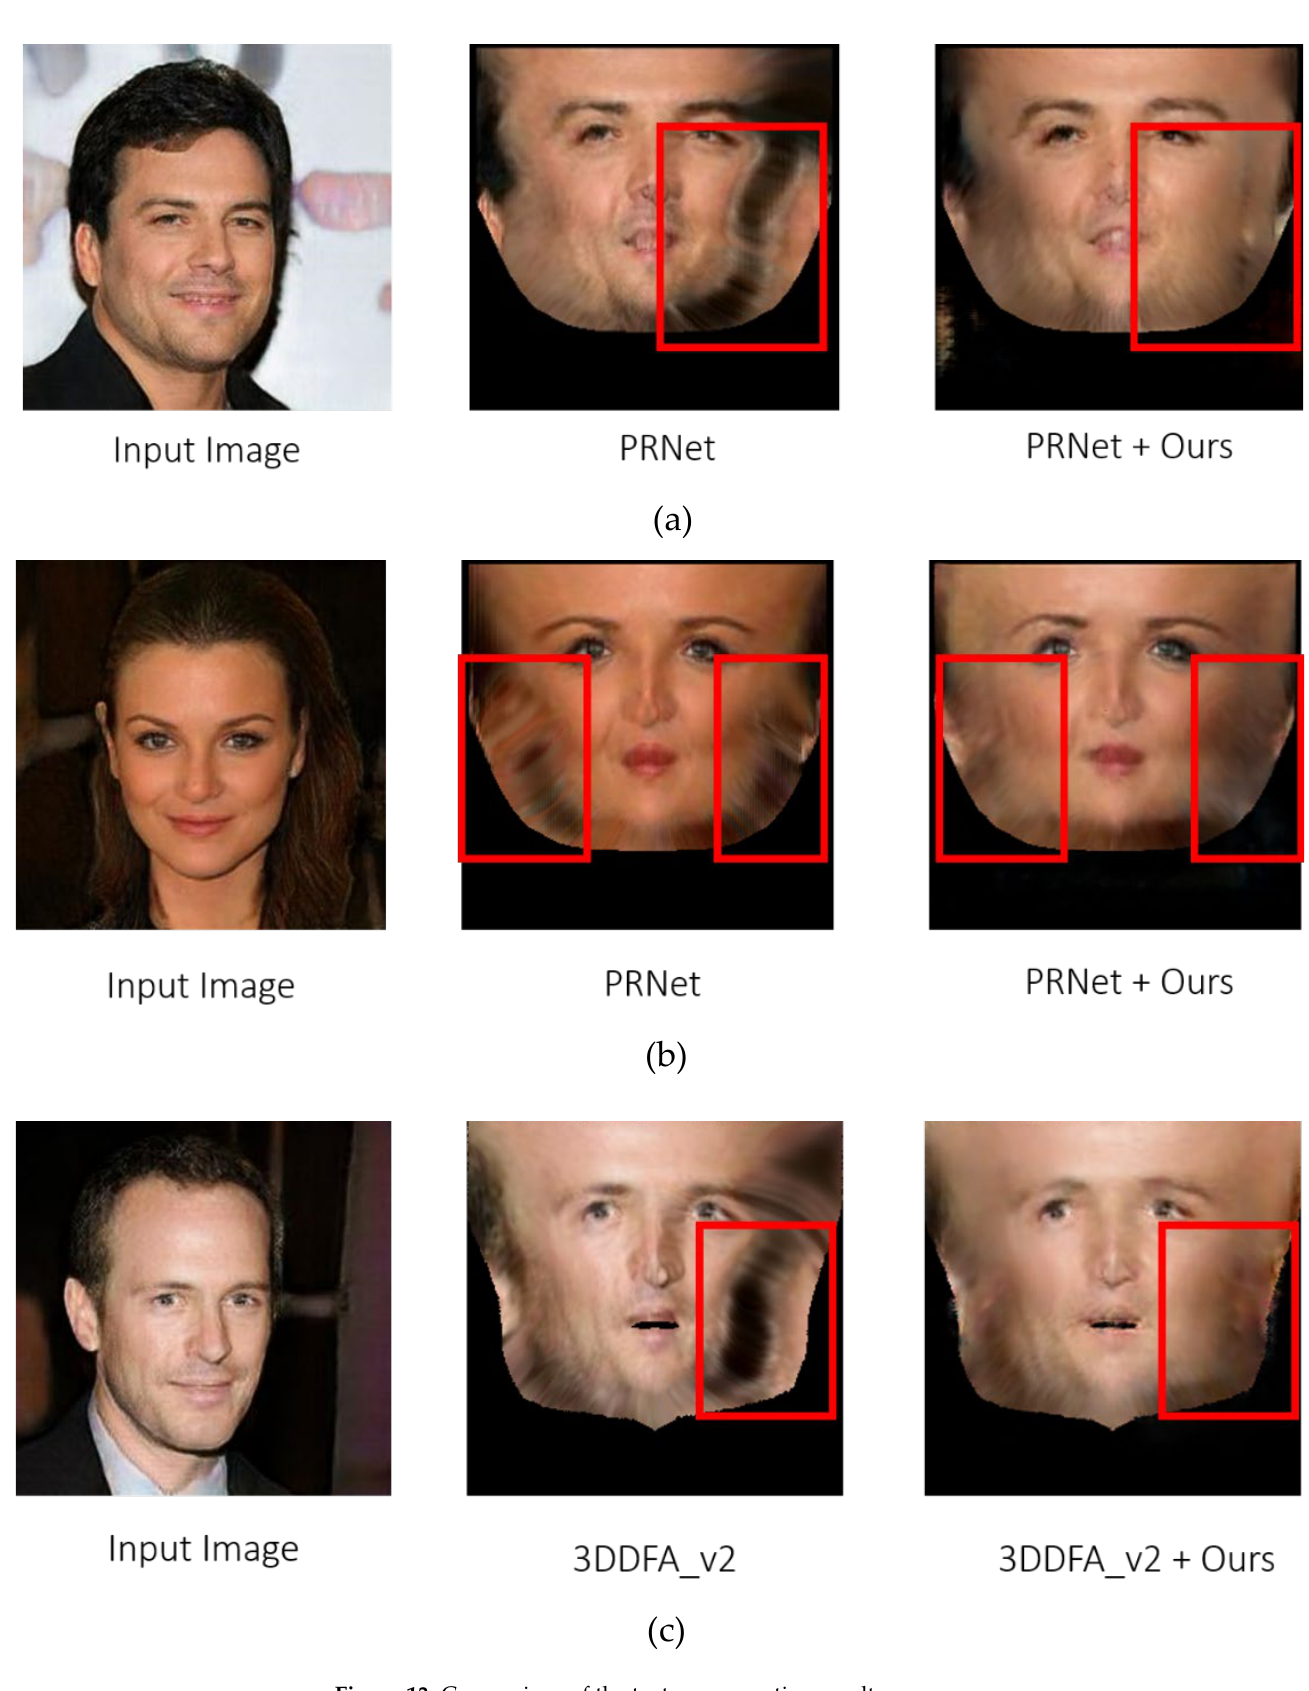
(b) Figure 12. Panoramic texture synthesis result. ( a ) Some sample texture synthesis result based on the FLAME model and ( b ) Some sample texture synthesis result based on the BFM model. 4.3. Panoramic Texture Generation Result for 3DMM-based 3D Face Reconstruction We qualitatively and quantitatively evaluated the UV texture results and presented the 3D visual effect of the method and then tested the results on another in-the-wild da- taset. The input image was first unwrapped to create a 256 × 256 texture, which was then translated into a panoramic texture of the same size by the texture translator (the structure is shown in Figure 9. We chose pix2pix [32] as our texture translator network, which was appropriately trained on the synthesized dataset training set. The hyperparameters for the training procedure were as follows: a batch size and learning rate of 64 and 0.0002, respectively and 45 epochs used for training. 4.3.1. Qualitative Evaluation